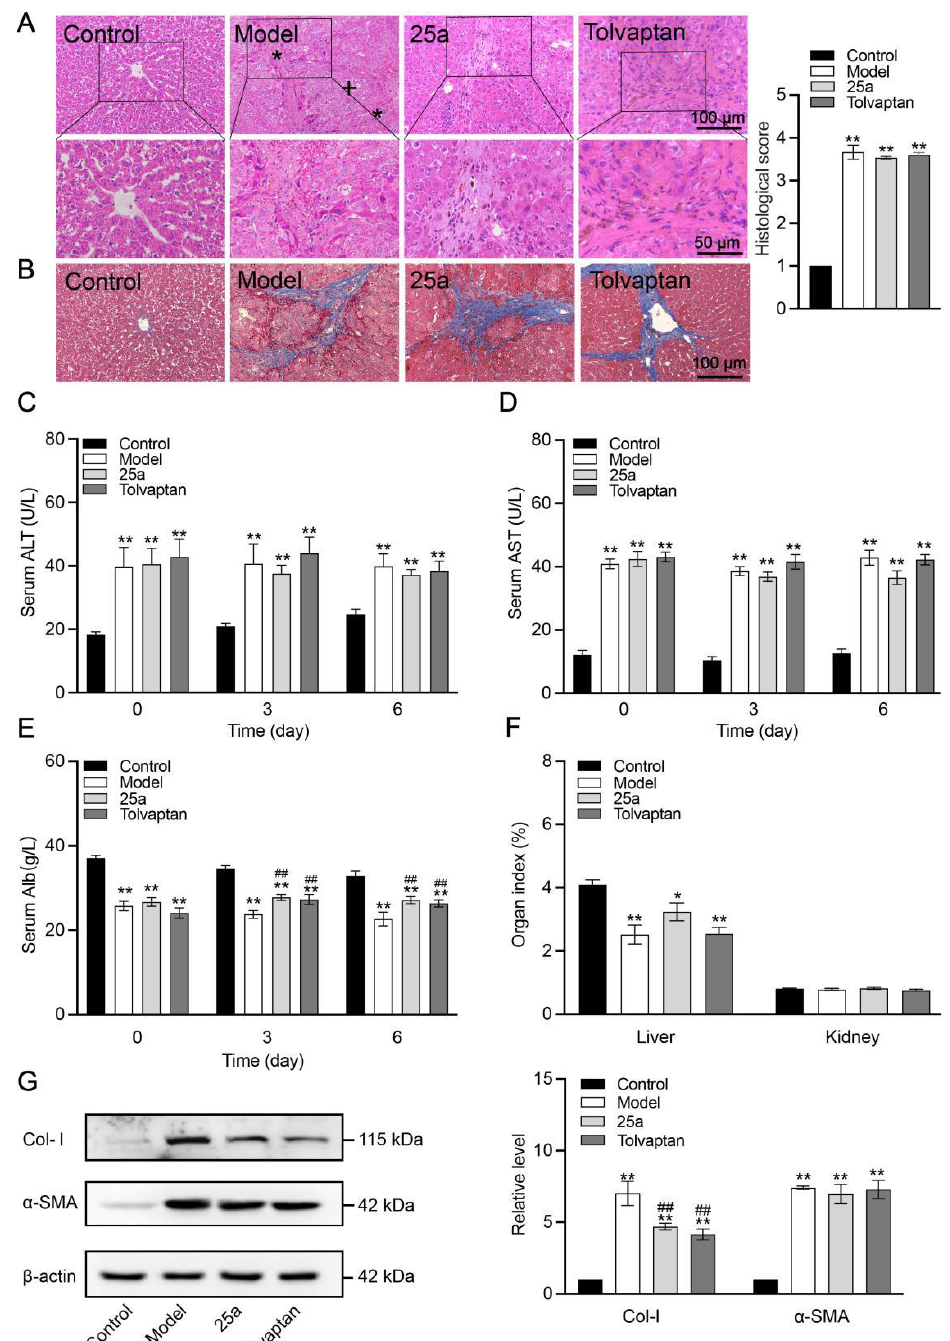
Figure 3. Liver tissue morphology and function in rats. ( A ) H&E-stained liver tissue sections (*, fibrosis; +, hydropic degeneration of hepatocytes) and histological score. ( B ) Masson-stained liver tissue sections. ( C ) Serum ALT. ( D ) Serum AST. ( E ) Serum albumin concentration. ( F ) Organ index. Above data are presented as means ± SE, n = 7. ( G ) Representative Western blots (left) and relative expression level of Col-I and α -SMA in liver quantified from Western blots (right). Data are presented as means ± SEM, n = 3. * p < 0.05 and ** p < 0.01 vs. control group; ## p < 0.01 vs. model group. The data were analyzed by one-way ANOVA with Tukey’s HSD post hoc test.